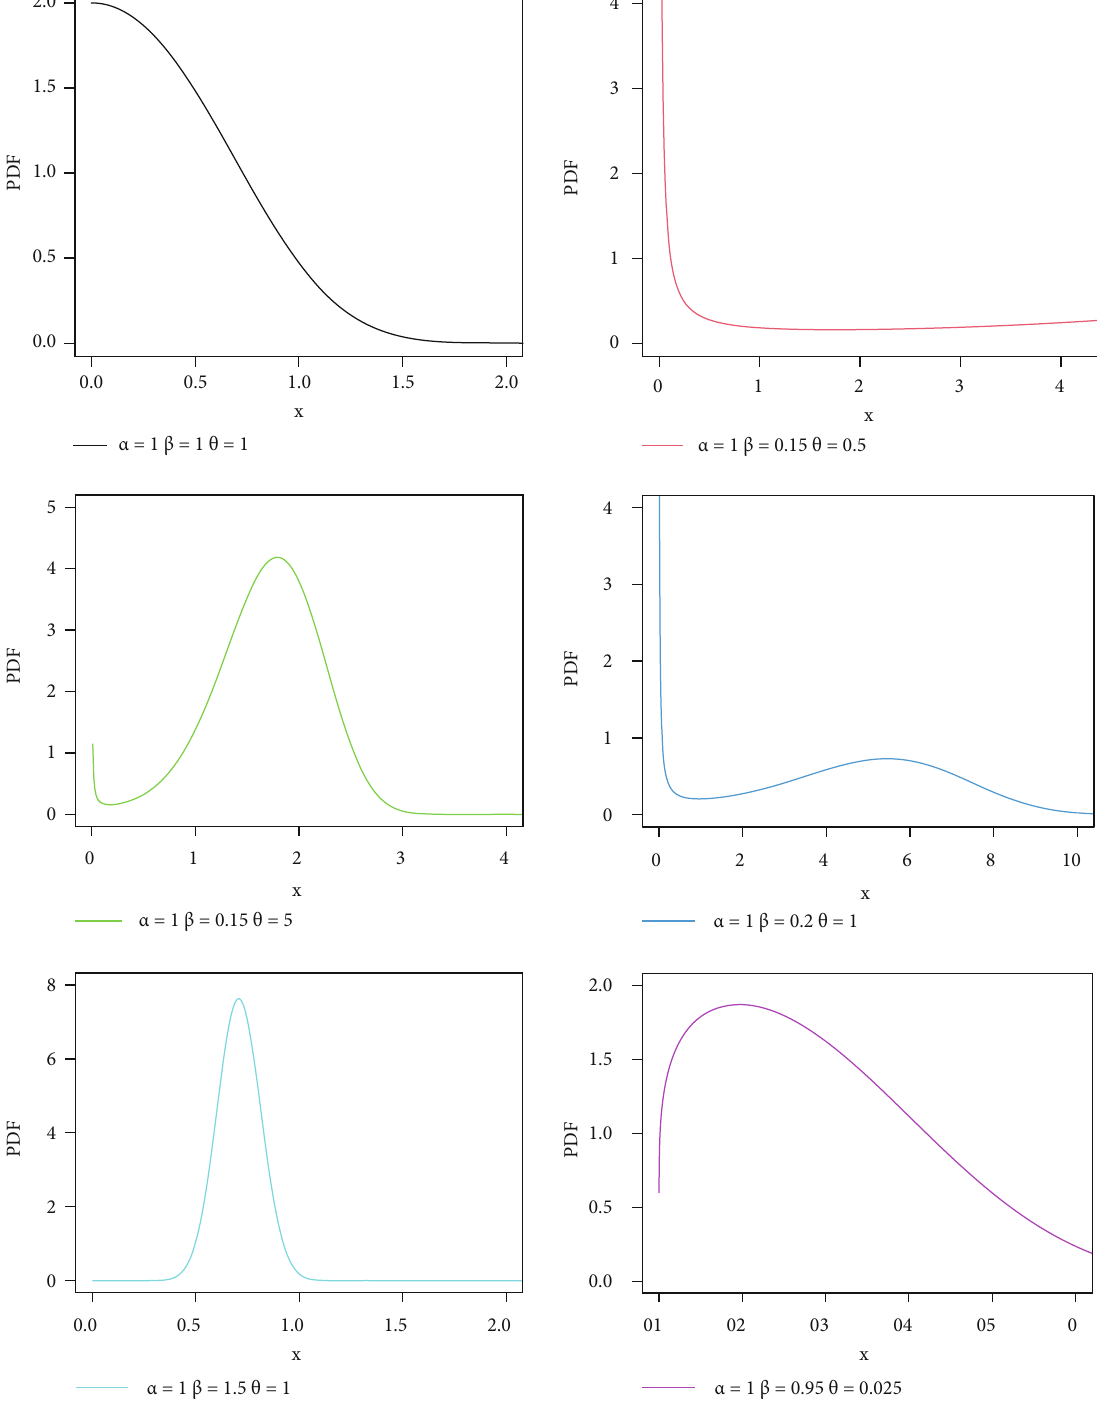
Figure 1: Plots illustrating the PDF of the TLWE